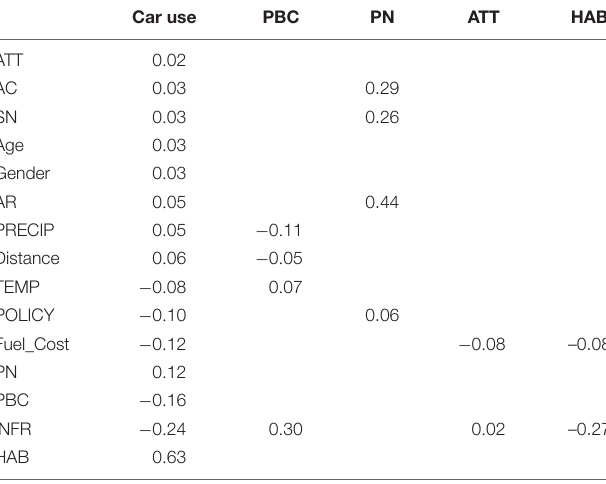
TABLE 5 | Path coefficients in the structural model. TABLE 6 | Total effects of the predictors in the